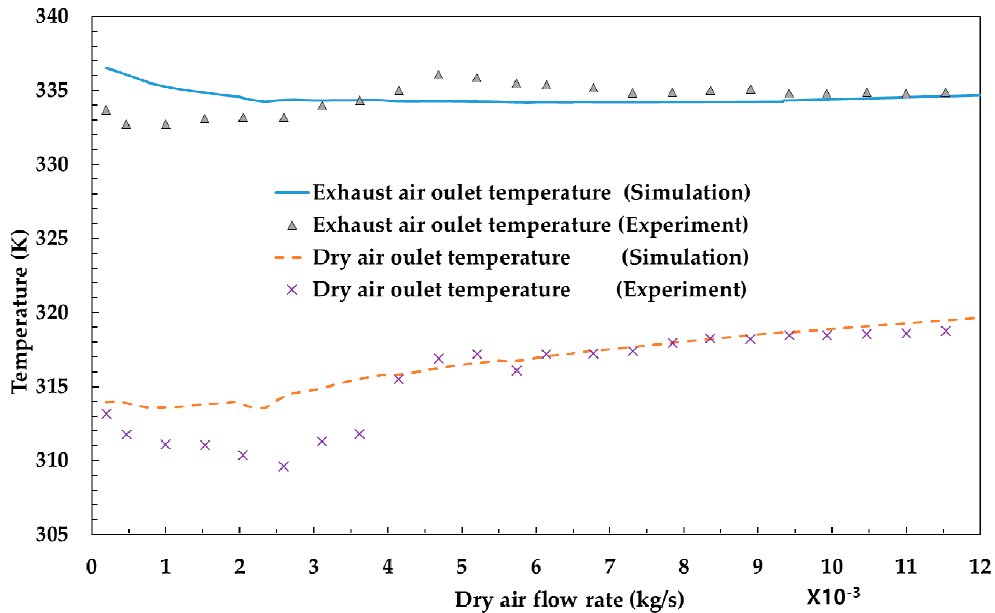
Figure 2. Comparison of temperature (K) with respect to dry air flow (kg/s) between the experiments and the simulation results.